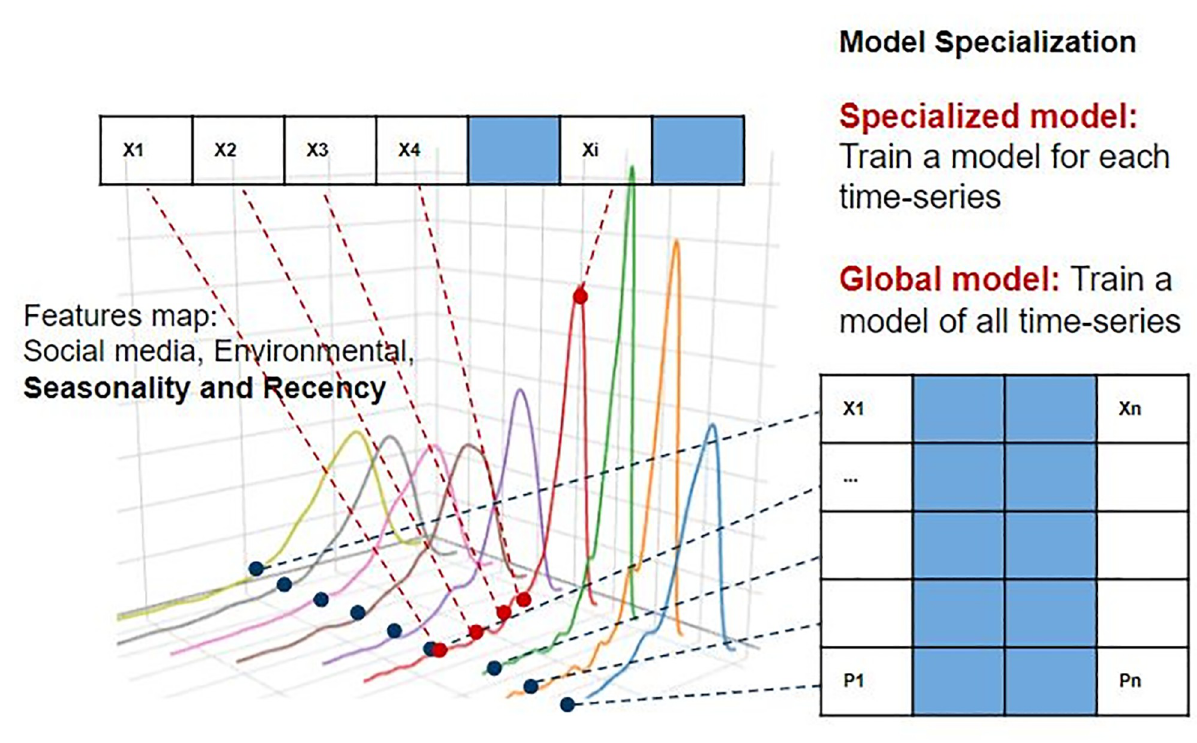
Fig 3. Model specialization—illustration of global vs. specialized